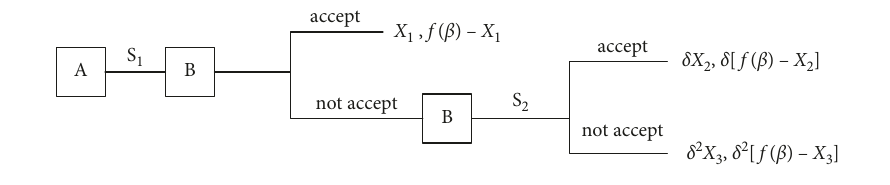
Figure 1: Continuous dynamic game between A and B .